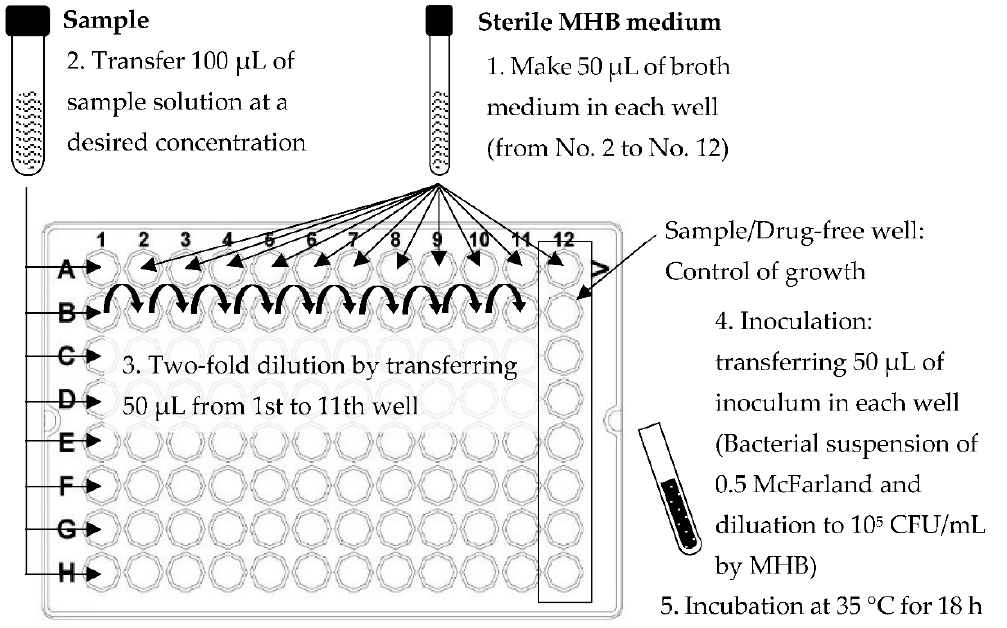
Figure 10. Modified broth microdilution for antibacterial testing as recommended by CLSI proto- col.